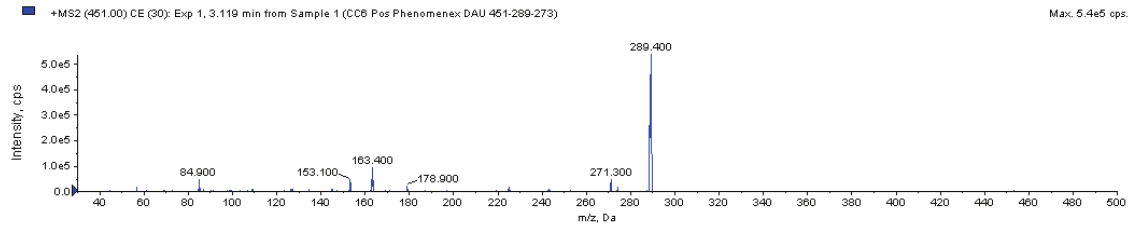
=3.12, potentially marein (ESI, positive R